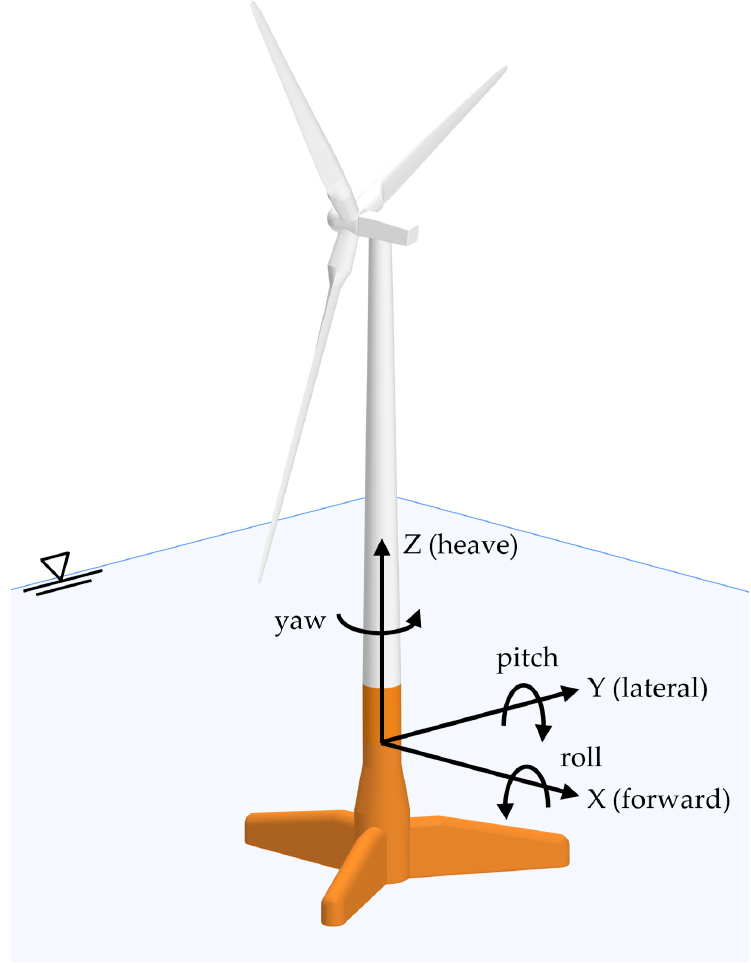
Figure 3. DoF of an